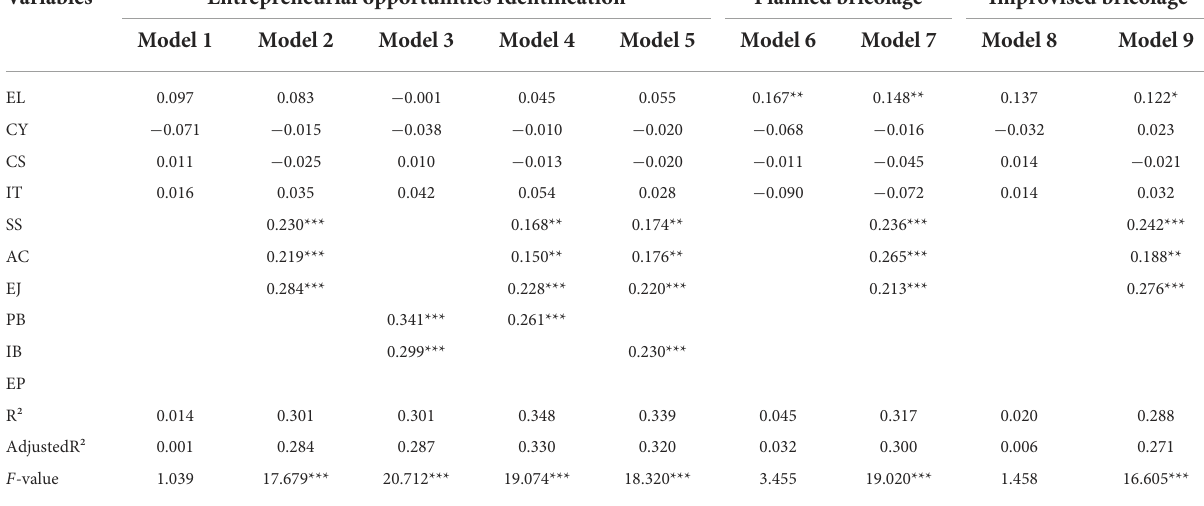
TABLE 4 Results of hierarchical regression analysis of intermediary effects.